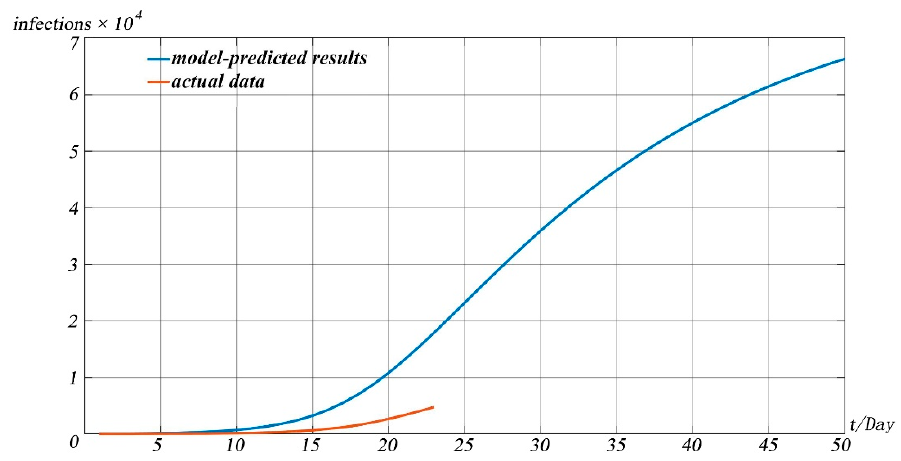
Figure 6. The model-predicted cumulative number of removed individuals in China’s mainland.